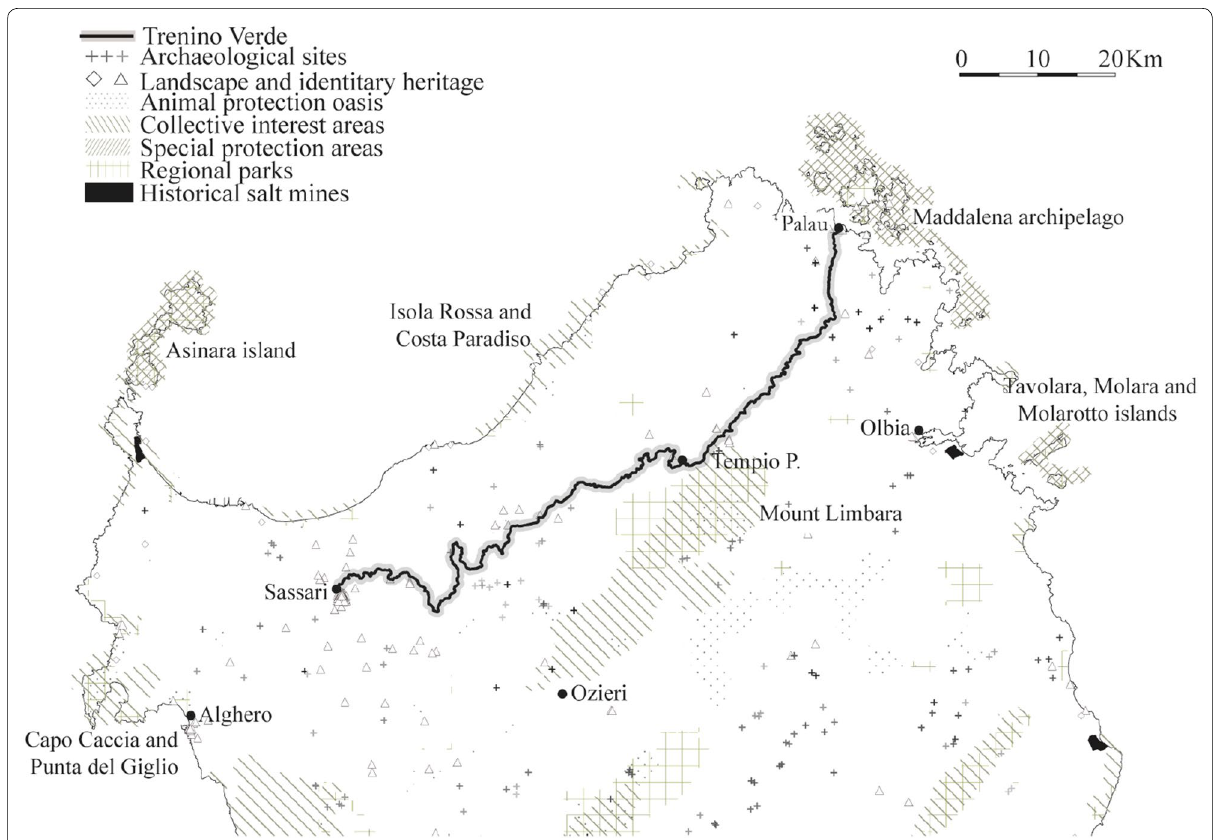
Fig. 6 Map of the Trenino Verde line and natural and cultural